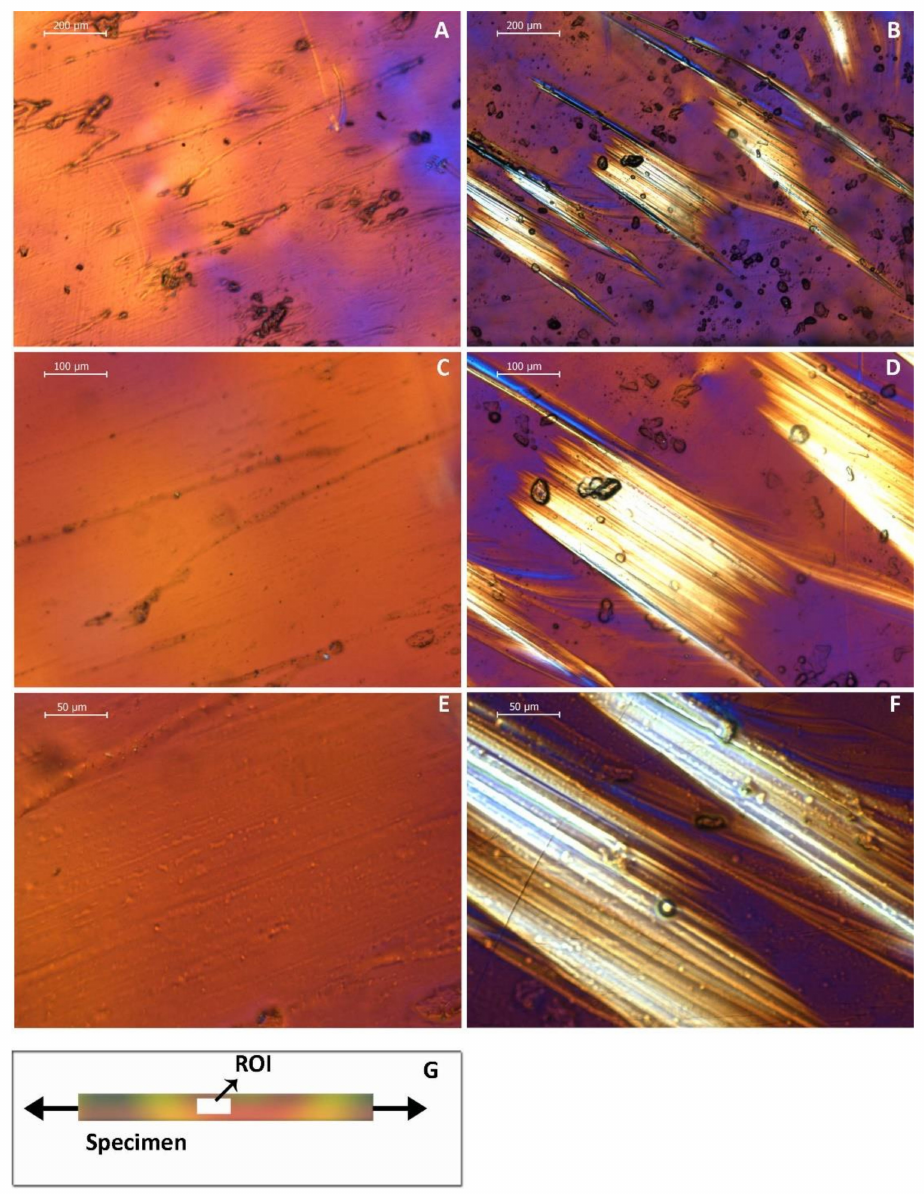
Figure 4. Optical microscope images under transmittance polarized illumination from a sample before ( A , C , E ) and after relaxation testing ( B , D , F ) at di ff erent magnifications. ( G ) The image shows that the horizontal axes of photographs are parallel to the long axis of the sample. After relaxation the sample reveals the development of bright regions with an orientation approximately 45 o to horizontal axis. The images were taken with original magnifications of 50 × ( A , B ), 100 × ( C , D ) and 200 × ( E , F